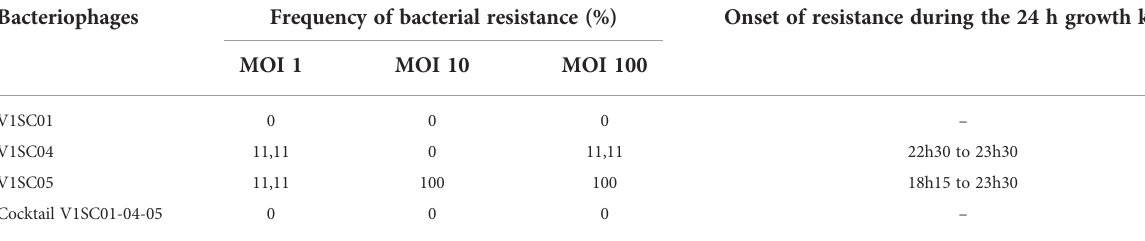
TABLE 2 Development of bacterial resistance against bacteriophages using bacteriophage alone or in cocktail. Bacteriophages Frequency of bacterial resistance